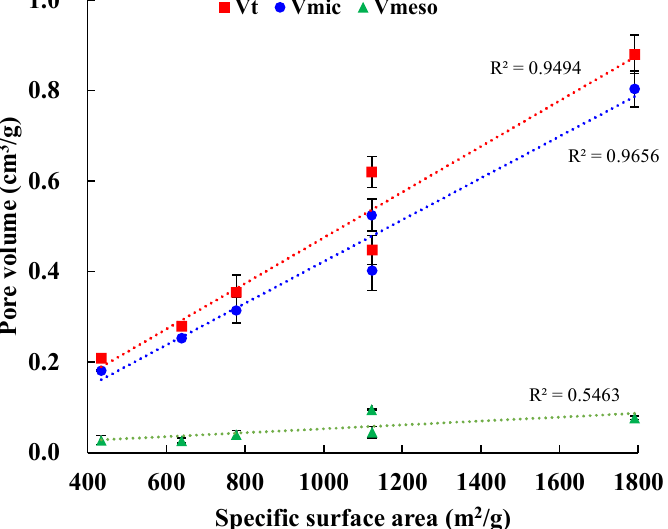
Figure 3. Correlation of activation temperature correlation of S BET with V t , V mic , V meso . Table 2. The specific surface area, pore volumes of ACs with KOH prepared at different tempera- tures.